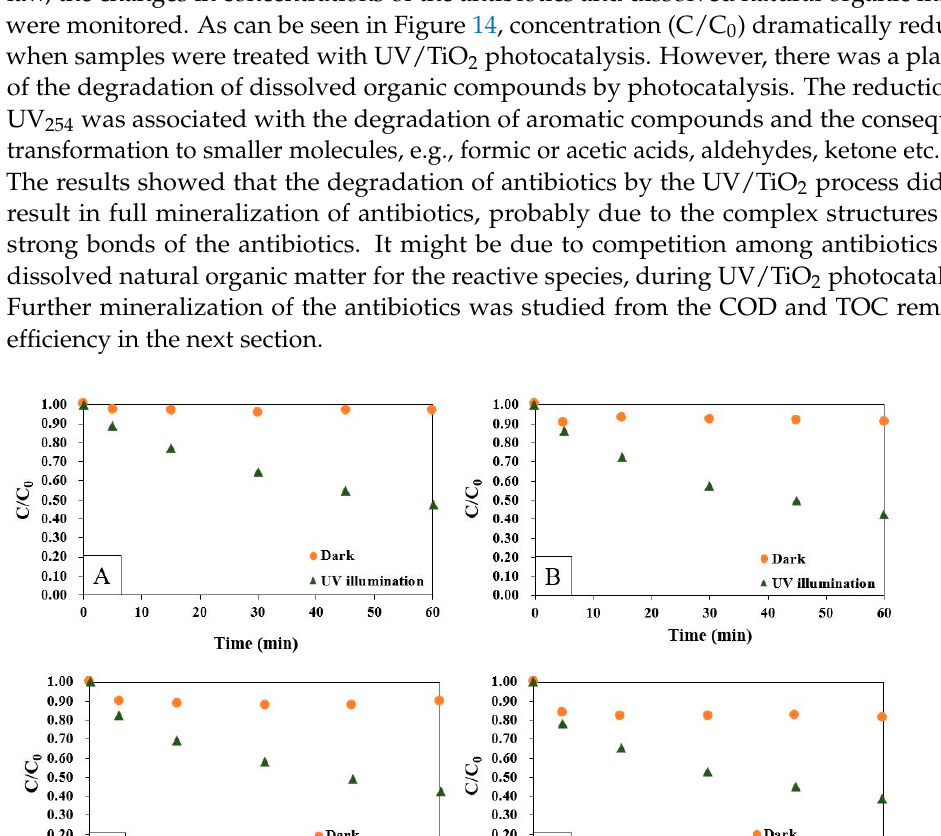
Figure 15. TOC removal under ( A ) dark conditions and ( B ) UV illumination, and COD removal under ( C ) dark conditions and ( D ) UV illumination.